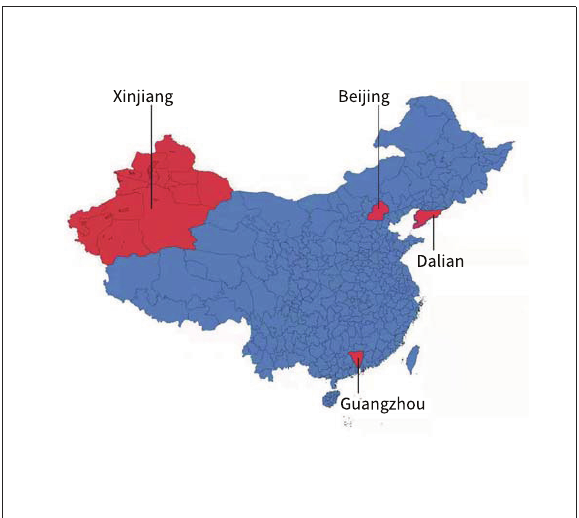
FIGURE1 Outbreaks in Beijing, Dalian, Xinjiang, and Guangzhou.